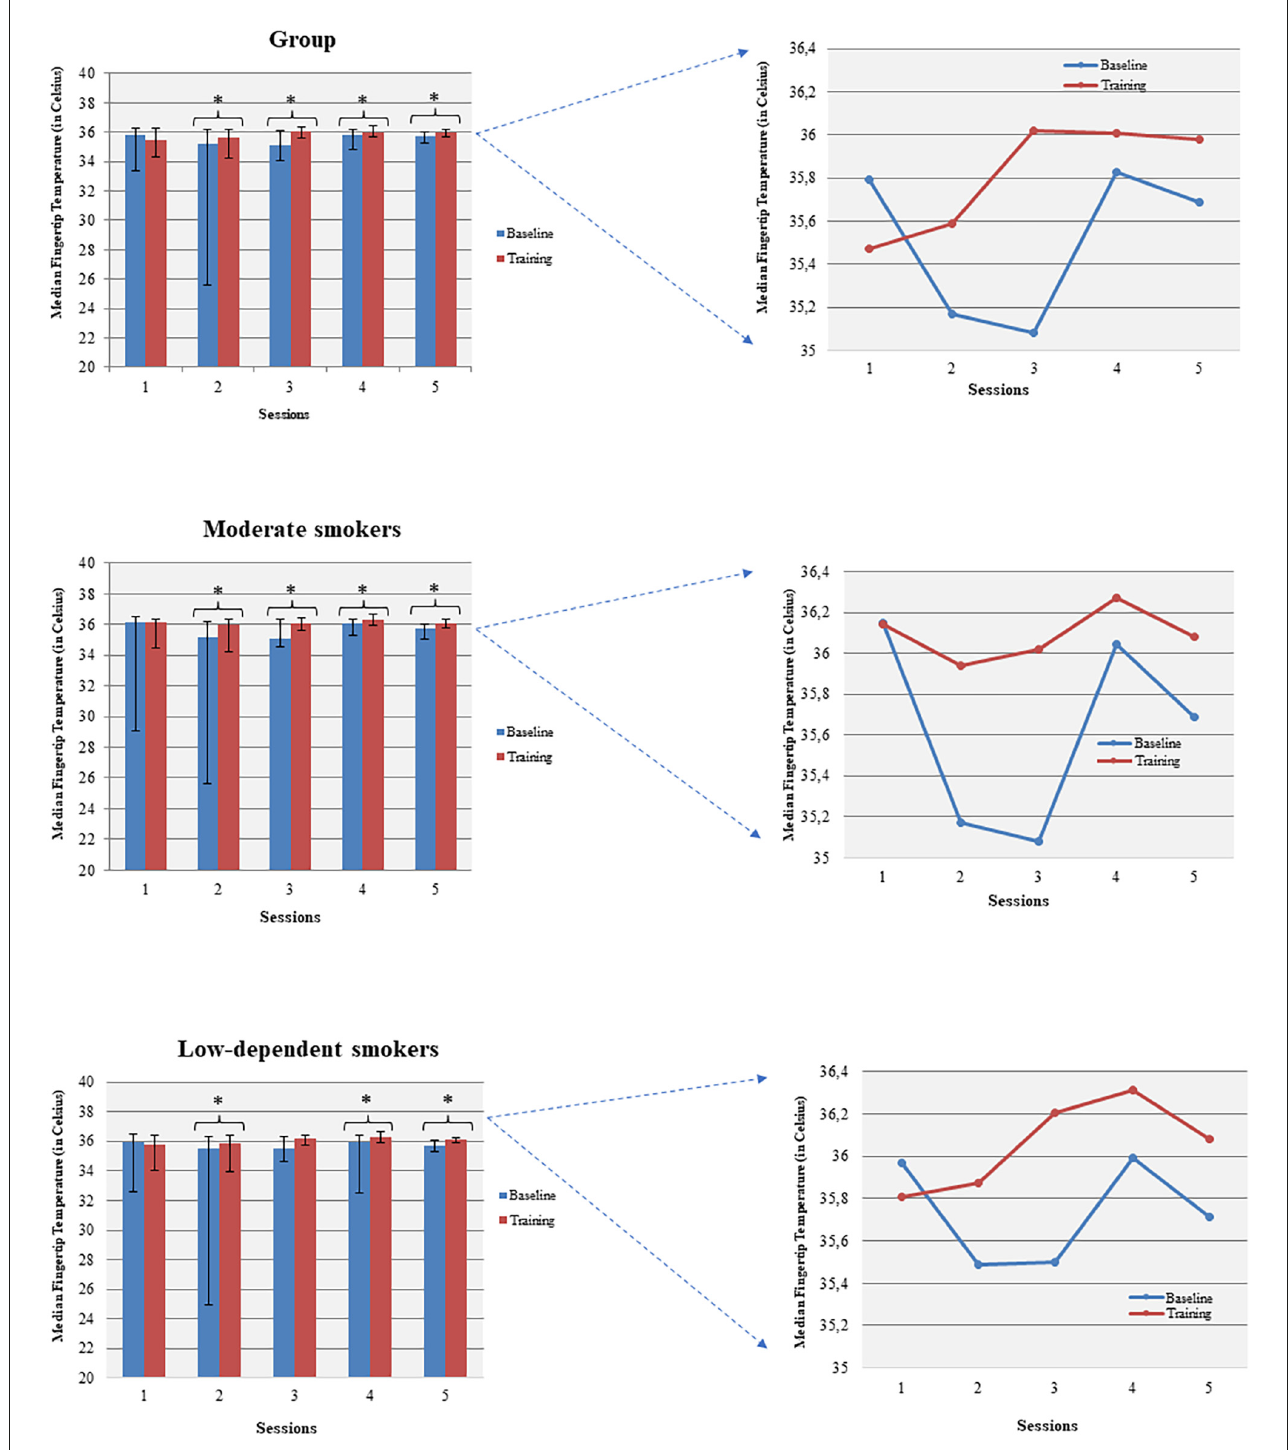
FIGURE4 Temperature enhancement was shown across baseline and corresponding sessions (within sessions BF learning). ∗ p < 0.05.